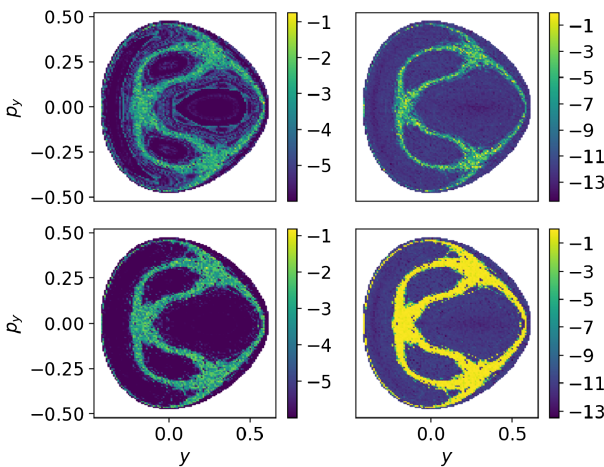
FIG. 27. Dynamic aperture of x ¼ 0 and E ¼ 1 = 9 surface projected on y - p plane. The left and right columns are FMA y and REM respectively. The top and bottom rows are T ¼ 512 and T ¼ 2048 respectively. The numerical integration step size was dt ¼ 10 − 3 .